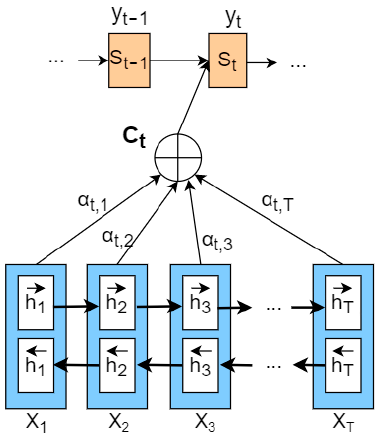
Figure 10. Schematic diagram of a tt ention mechanism